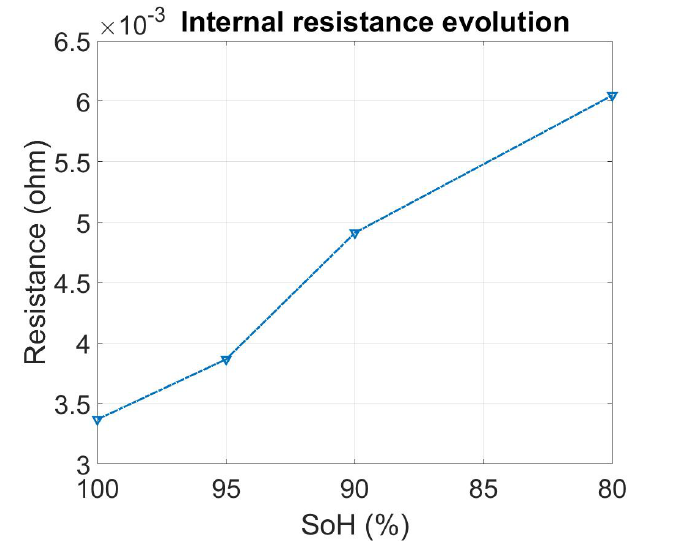
Figure 9. Evolution of the internal resistance with